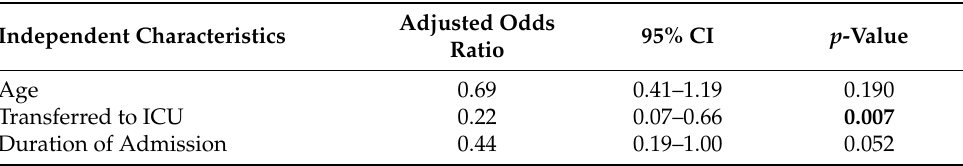
Table 4. Logistic regression between independent variables that showed statistically significant association with treatment